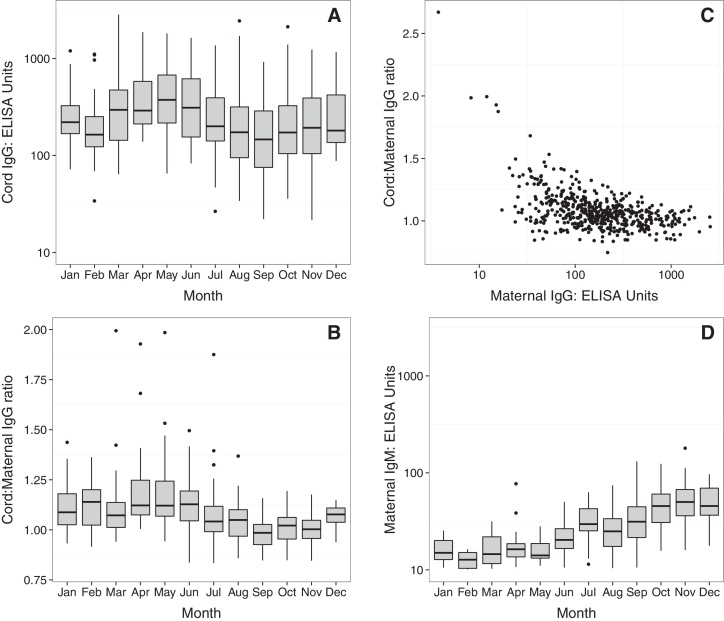
Temporal anti-S. sonnei-O antibody cord titers and transplacental transfer dynamics. (A) Anti-S. sonnei-O IgG cord plasma titers shown by month of birth on a log10 scale. (B) The ratio of cord:matneral anti-S. sonnei-O IgG titer by month of birth. (C) Scatterplot showing the relationship between maternal anti-S. sonnei-O IgG titers and the ratio of cord:maternal plasma transfer. (D) Maternal anti-S. sonnei-O IgM titers shown by month of birth on a log10 scale.